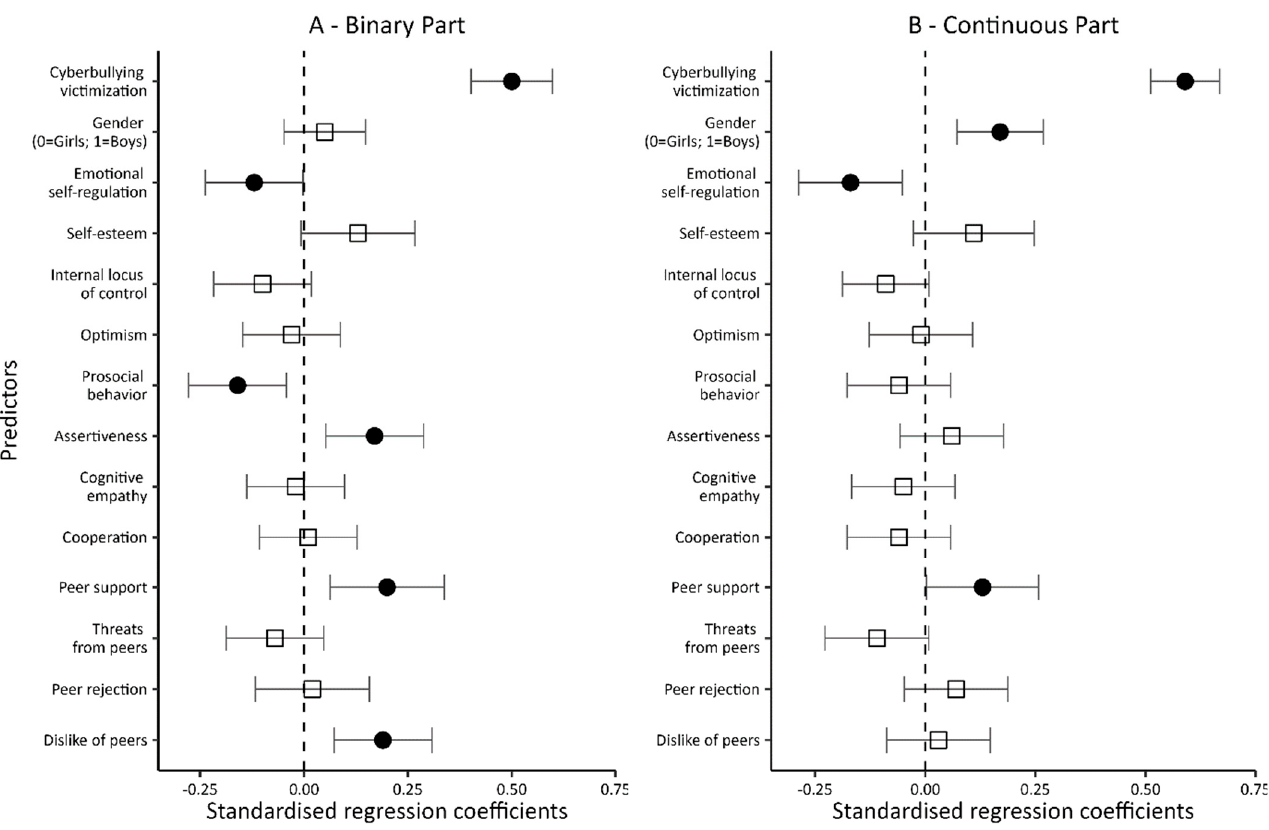
Figure 4. Model 2. Standardised regression coefficients with 95% confidence intervals. Note: black circle-coefficient significant at 0.05; white square-coefficient insignificant ( p > 0.05); tails = standard errors.